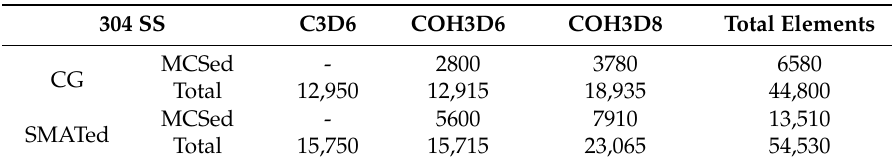
Table 1. The number of the different elements for the coarse-grained (CG) and surface mechanical attrition treatment (SMAT)-ed 304 SS.